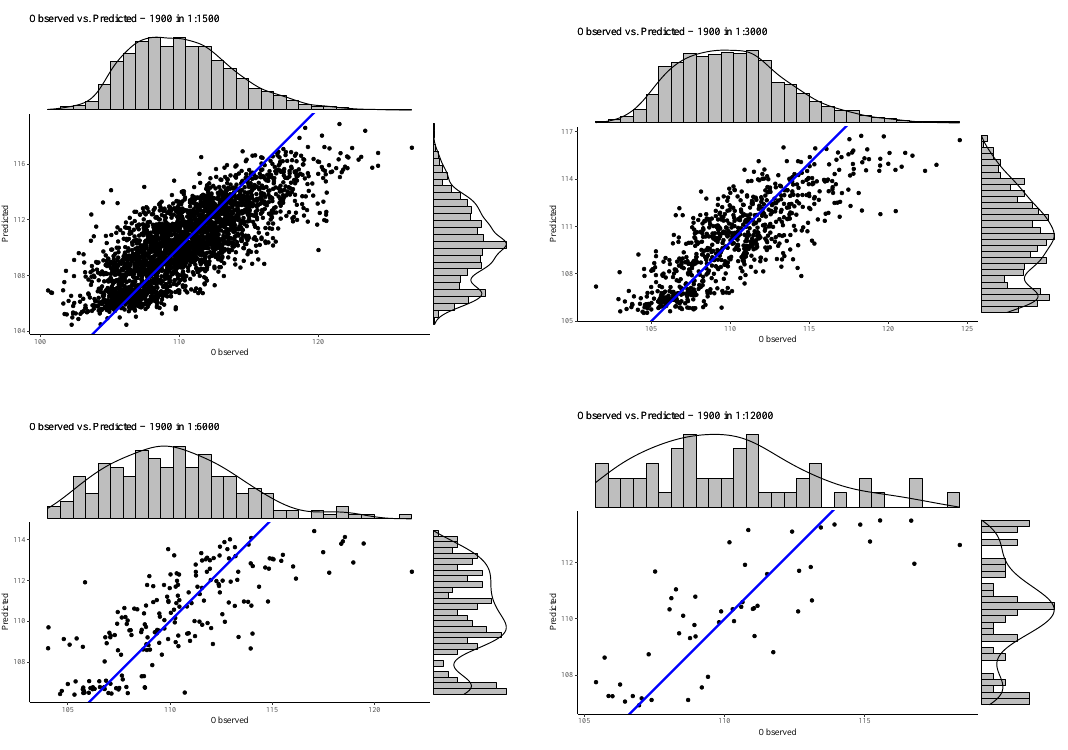
Figure 15. Marginal plots in the four different spatial aggregation resolutions showing the predicted PV fractions on the y -axis and the observed values on the x